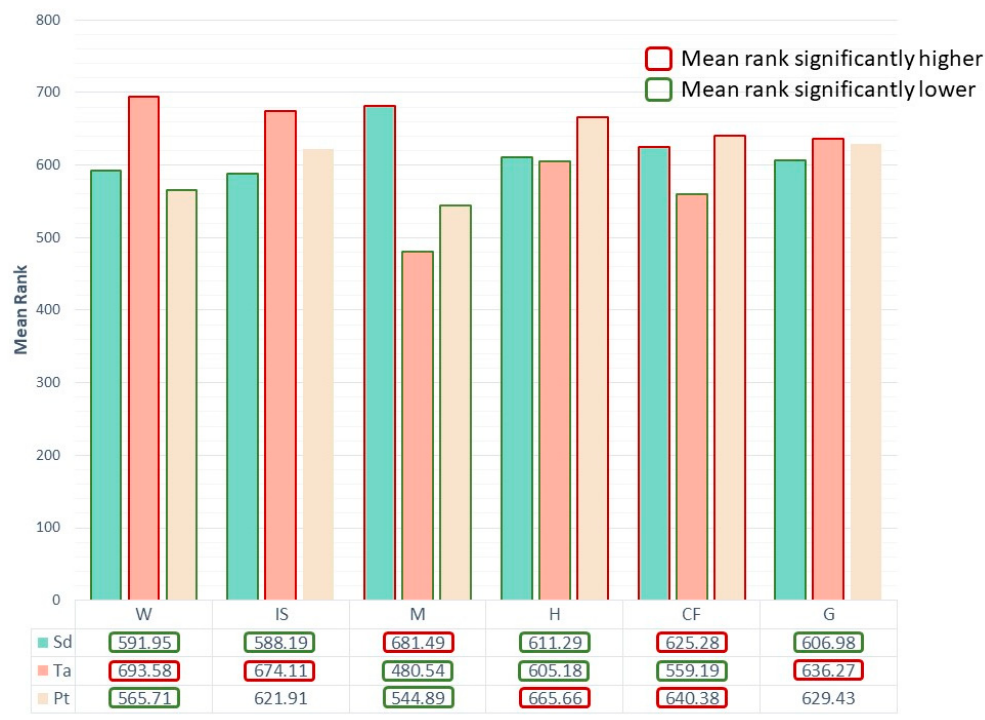
Figure 5. Kruskal-Wallis one-way ANOVA independent sample multiple comparison of mode of transportation. Note: W: waterscape; IS: ice and snow; M: meadow; H: heritage; CF: customs and festivals; G: gastronomy; Sd, Self-driving; Ta, Travel Agency; Pt, Public transportation.